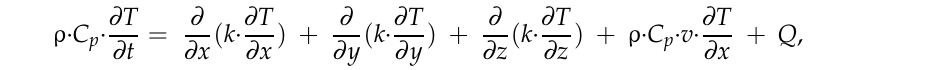
Figure 2. ( a ) Schematic showing the thermal behavior of the powder bed under laser irradiation. ( b ) 3D finite-element (FE) model. ( c ) Schematic showing the transfer of laser radiation into the powder bed.